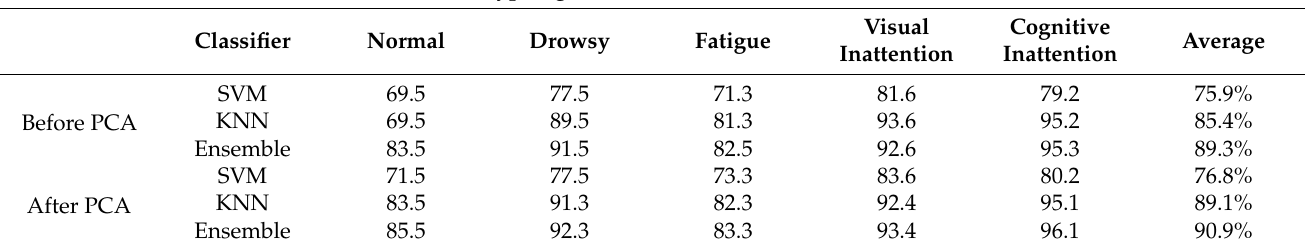
Table 4. Performance of EOG in hypovigilance state detection. Table 4 . Performance of EOG in hypovigilance state detection. Performance of Hypovigilance Detection on the Fusion of